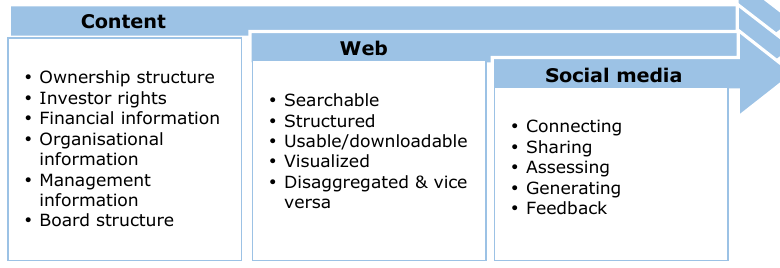
Fig. 2. Content and channel determinants of e-transparency of finance